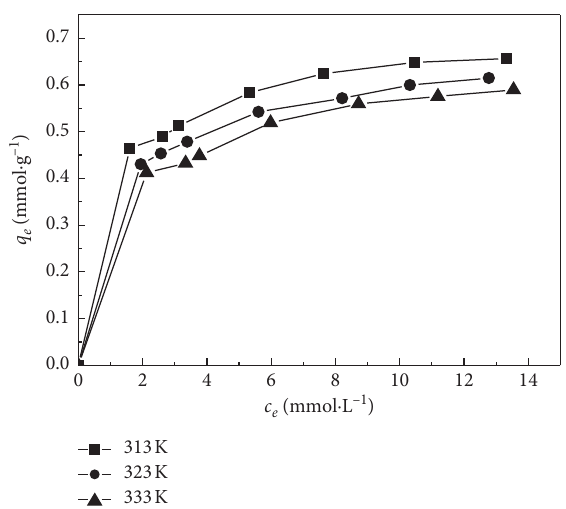
Figure 10: Equilibrium isothermal adsorption of DBTover Mn/AC : 20mL; c 0 : 6.25, 7.81, 9.38, 12.50, (adsorbent: 0.2g 2wt. %; v oil 15.63, 18.75, and 21.88mmol · L − 1 DBT; adsorption time: